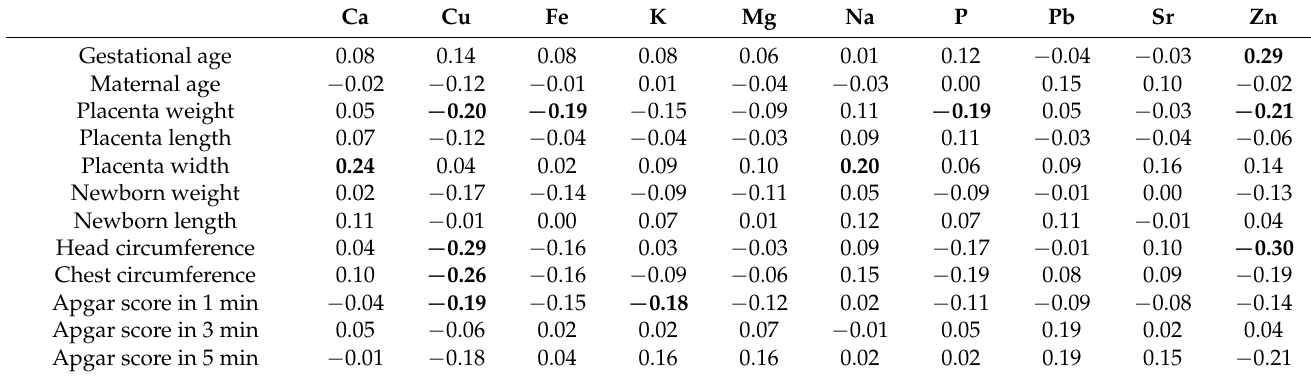
Table 8. Spearman’s rank correlation cofactors between biological parameters of the mother, newborn, and placenta, and the concentrations of Ca, Cu, Fe, K, Mg, Na, P, Pb, Sr, and Zn in the cord blood (bolded is statistically significant, p < 0.05).